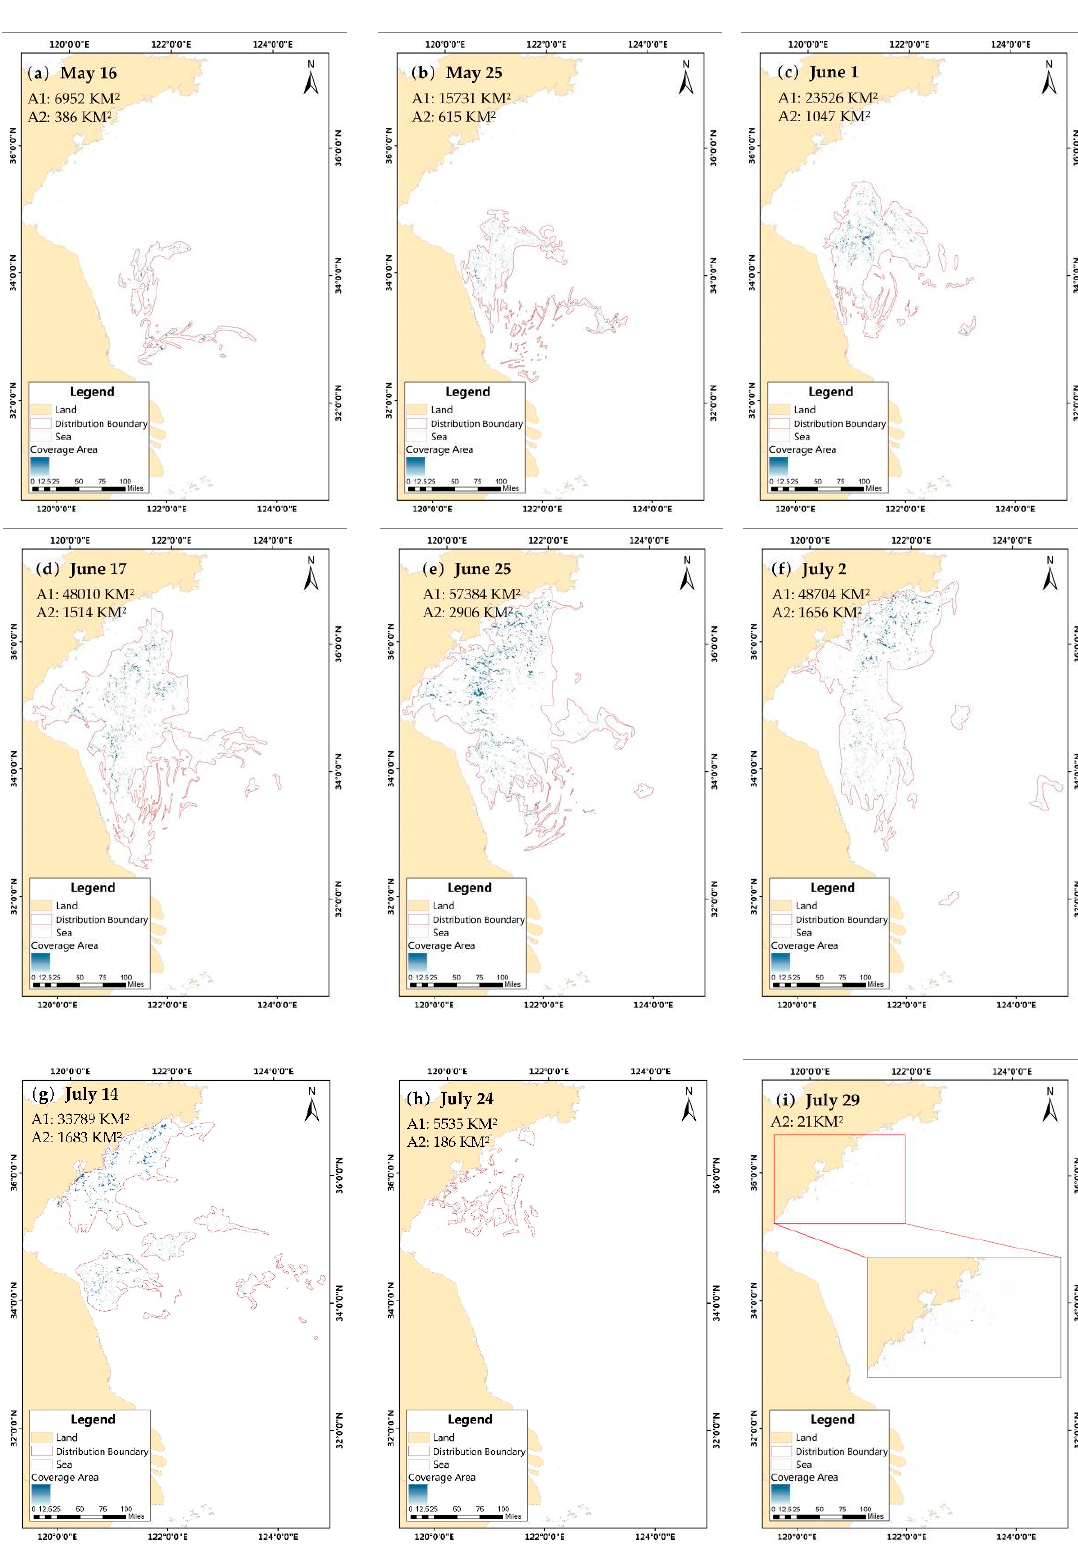
Figure 5. Spatial and temporal distribution of U. prolifera in the Yellow Sea, China in 2017. ( a ) The situation of U. prolifera on April 30. ( b ) The situation of U. prolifera on May 7. ( c ) The situation of U. prolifera on May 18. ( d ) The situation of U. prolifera on May 27. ( e ) The situation of U. prolifera on June 4. ( f ) The situation of U. prolifera on June 14. ( g ) The situation of U. prolifera on June 18. ( h ) The situation of U. prolifera on June 26. ( i ) The situation of U. prolifera on July 13.